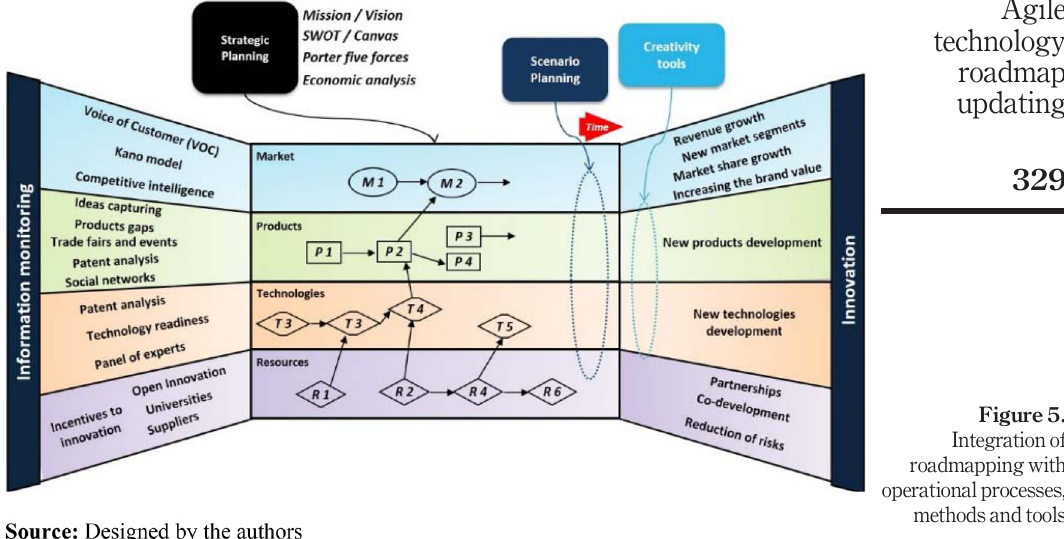
Figure 5. Integration of roadmapping with operational processes, methods and